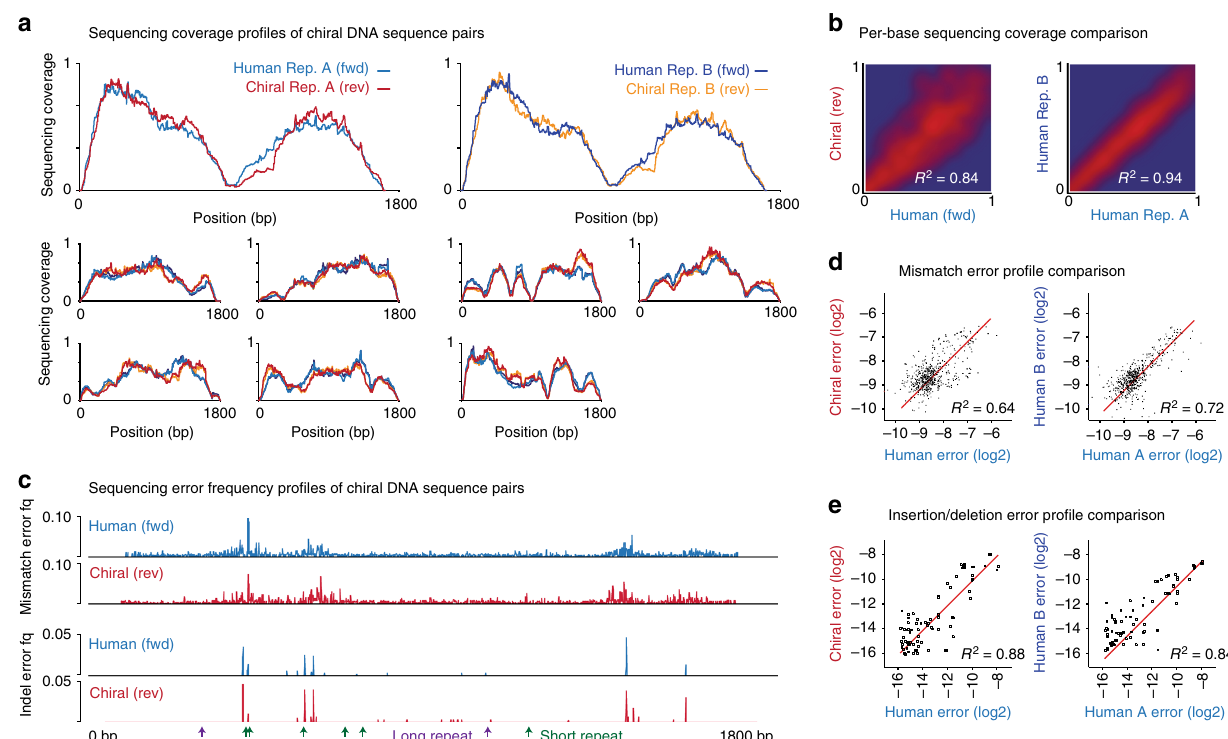
Fig. 2 Matched performance of chiral DNA sequence pairs during next-generation sequencing. a Normalized sequencing coverage within synthetic chiral DNA sequence pairs ( n = 8). Coverage pro fi les for human ( fwd ; blue and navy) and chiral ( rev ; red and orange) sequences are shown for two replicate NGS experiments. b Density scatter plots show the concordance of per-base coverage pro fi les between paired human and chiral ( fwd/rev ) sequences (left). For comparison, the concordance of identical human ( fwd/fwd ) sequences between replicate experiments is also shown (right). c Mismatch and indel sequencing error frequency pro fi les within one chiral pair of DNA sequences. d , e Scatter plots show concordance of mismatch ( d ) and indel ( e ) sequencing error frequency pro fi les between synthetic human and chiral ( fwd/rev ) DNA sequence pairs (left). For comparison, the concordance of identical human ( fwd/fwd ) sequences between replicate experiments is also shown